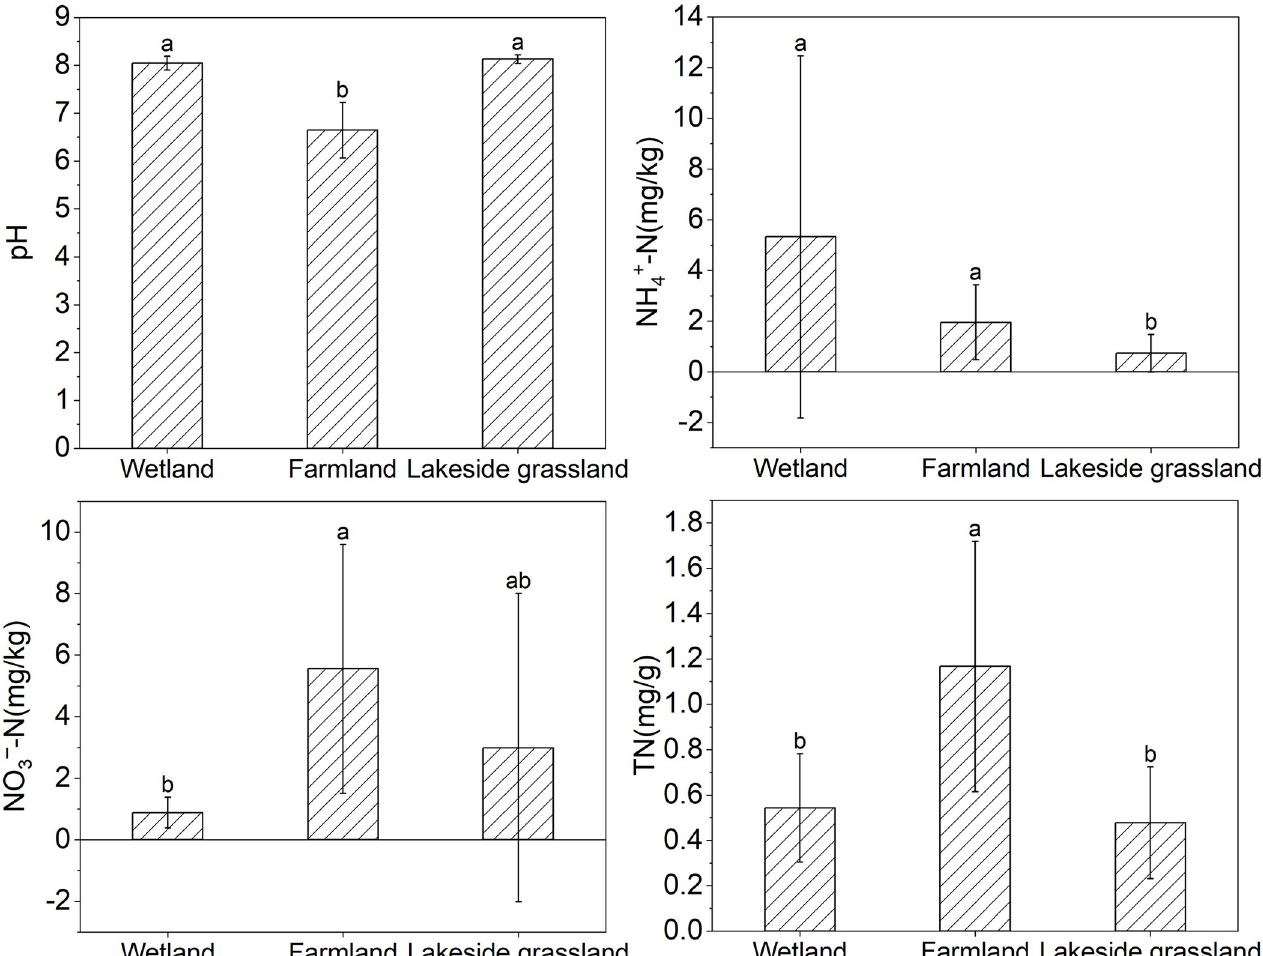
Fig 3. Soil properties in different habitats. Error bars represent standard deviation of the mean (n = 5). TN: total nitrogen; NO 3– -N: nitrate nitrogen; NH 4+ - N: ammonium nitrogen. Different lowercase letters indicate significant differences ( p <